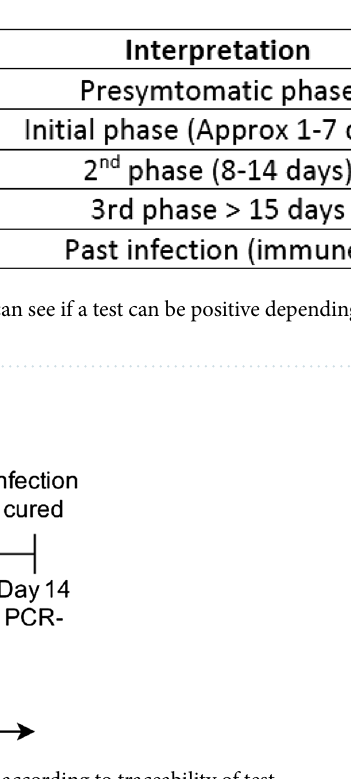
Figure 3. Estimation of the patient exposure to the virus according to traceability of